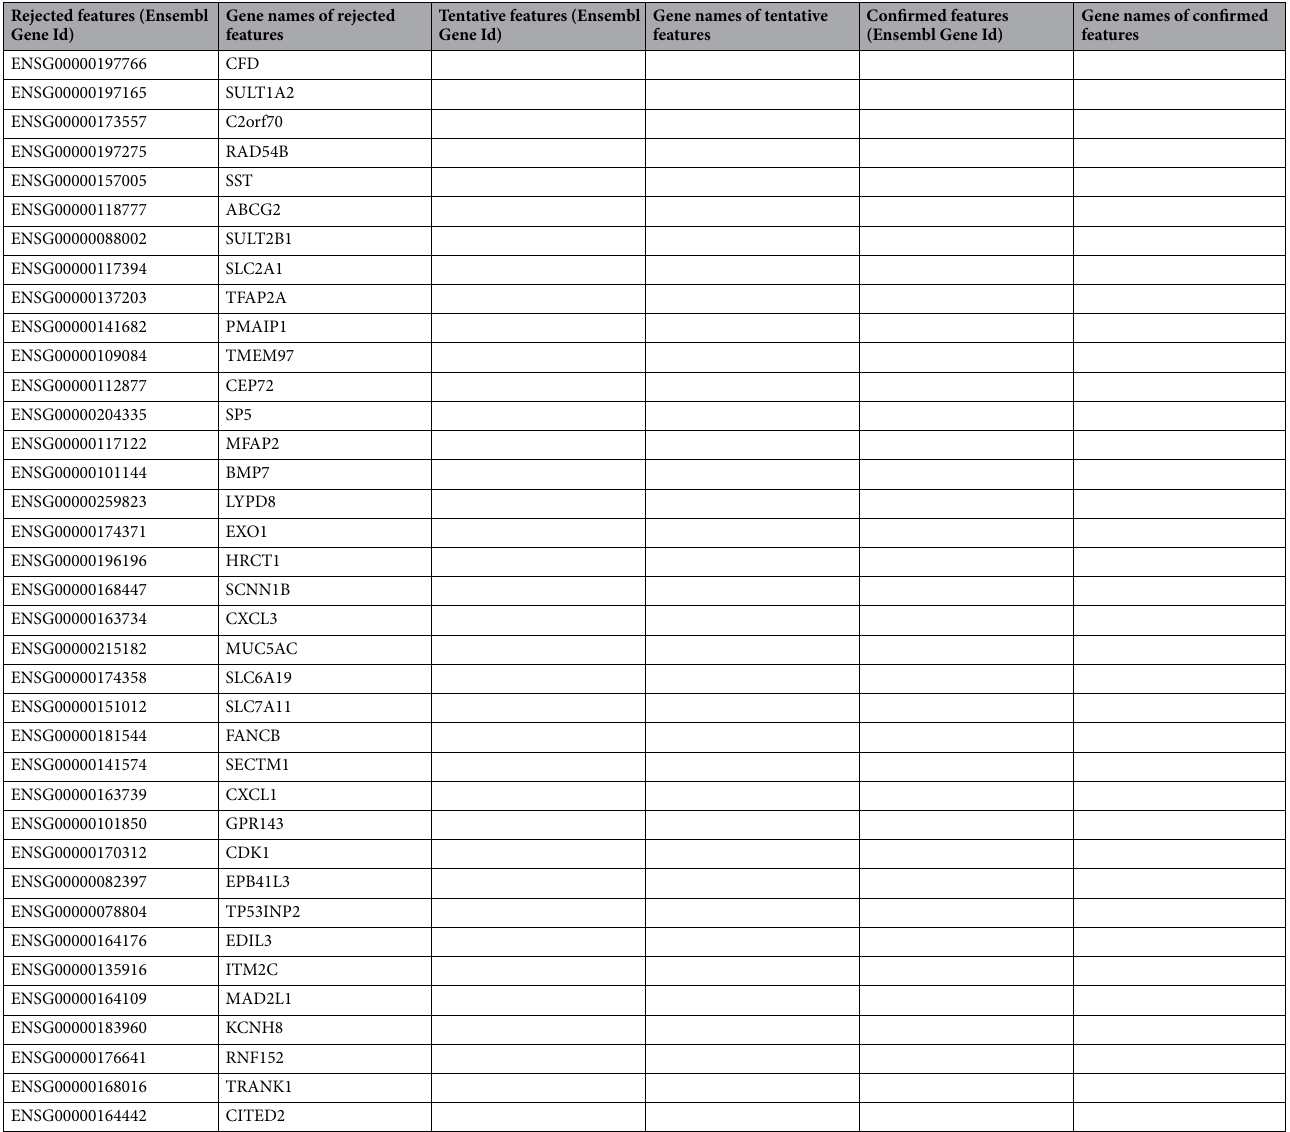
Table 3. List of rejected, tentative and confirmed features selected through boruta algorithm.